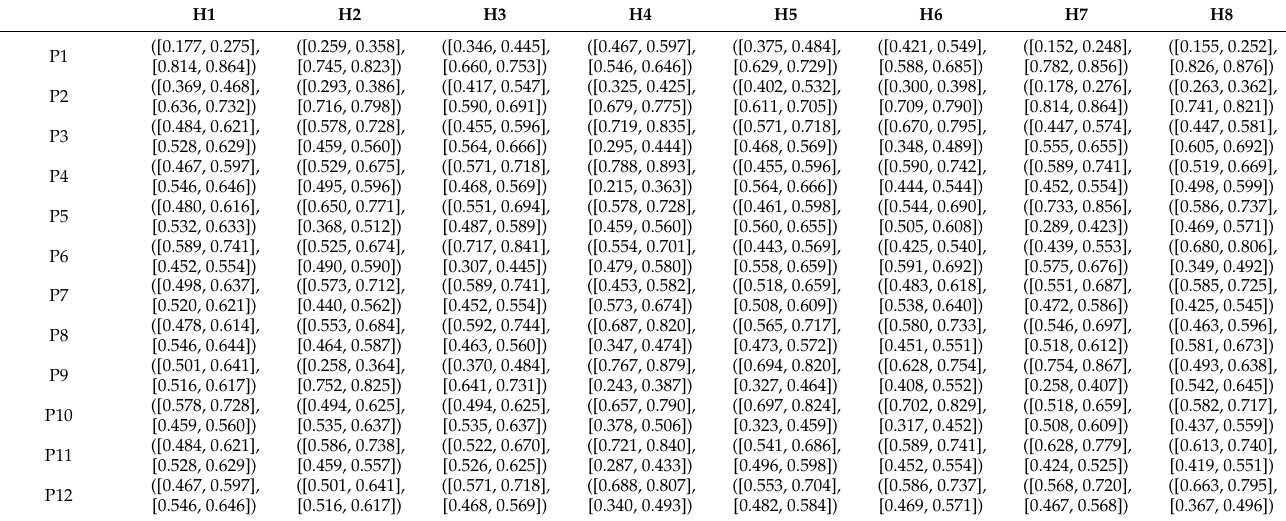
Table 6. A-IPF-DM of WTE technology for MSW treatment alternatives.